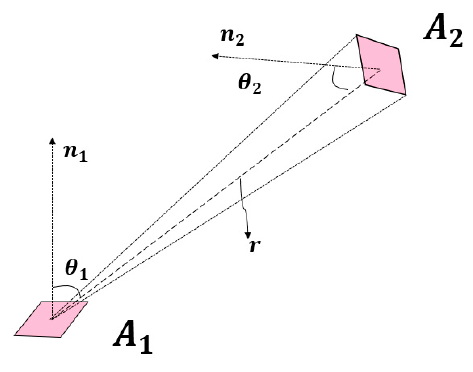
Figure 2. The view factor between two surfaces.